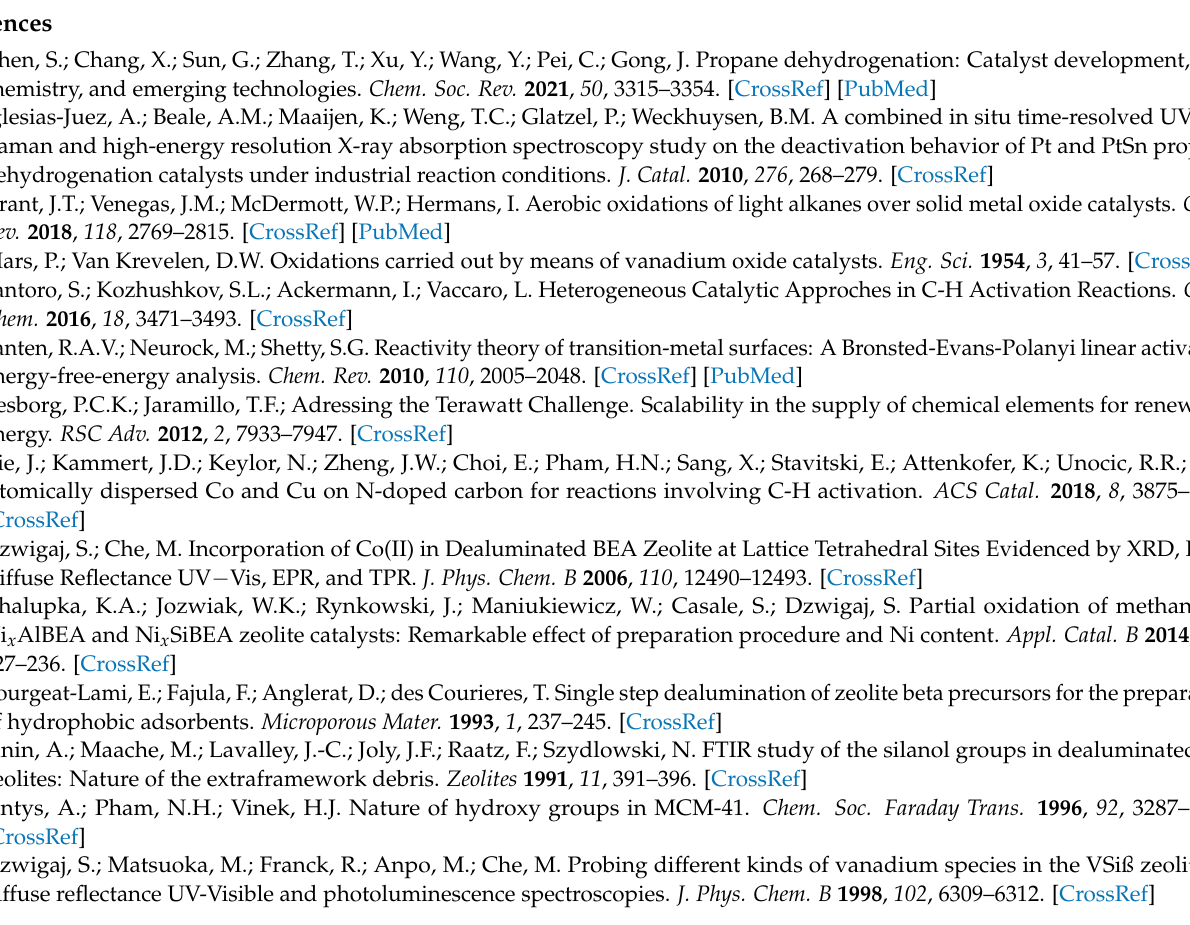
Figure S4: 1 H- 29 Si CP MAS NMR of SiBEA, Co 1.0 SiBEA(III) and Co 5.0 SiBEA(III); Figure S5: FTIR difference spectra in hydroxyl (A) and carbonyl (B) stretching range of HAlBEA (a), Co 1.0 HAlBEA(II) (b) and Co 5.0 HAlBEA(II) (c) after CO adsorption at 173 ◦ C with equilibrium pressure 133 Pa of CO and secondary vacuum evacuation for 5 min (pressure < 5 × 10 − 2 Pa); Figure S6: FTIR difference spectra in hydroxyl (A) and carbonyl (B) stretching range of SiBEA (a), Co 1.0 SiBEA(I) (b), Co 5.0 SiBEA(I) (c), Co 1.0 SiBEA(III) (d) and Co 5.0 SiBEA(III) (e) after CO adsorption at 173 ◦ C with equilibrium